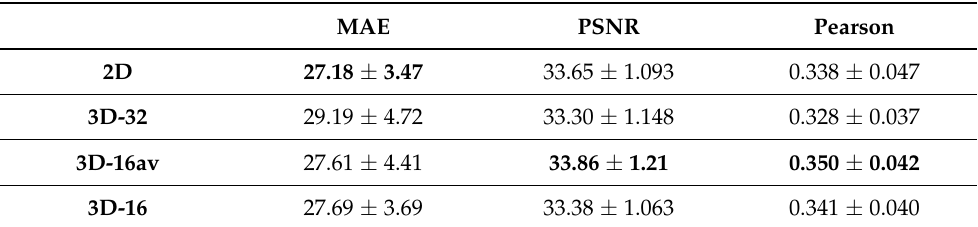
Table 12. Head dataset Soft-tissue with Residual-Net. Mean Absolute Error, PSNR and Pearson coef- ficient within the bone on the head data set obtained using Residual net with different convolutions and reconstructions.